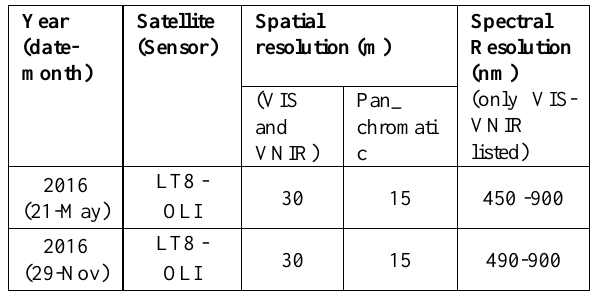
Table 1. Satellite imagery used for Albenga case study Calibrated and cloud free above the area of interest, the two satellite images regard distinct moments in the year 2016 – end of May 2016 (start of the summer season) and end of November 2016. The latter one was the first available image after the last major flood event that has shook this Liguria locality has occurred, between 24 th and 25 th of November 2016, as testified by numerous national and local newspaper articles. The images were used to observe expected changes of the river flow and of the mud deposit in the area, due to the recent flooding event. Images used are described in details in Table 1.